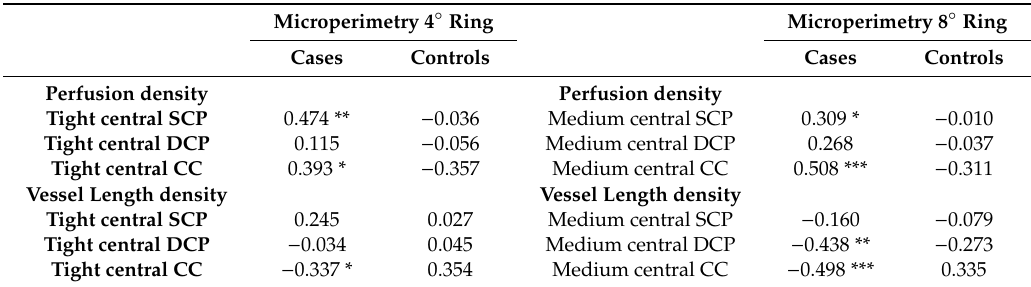
Table 7. Pearson’s correlation coe ffi cients between 4 ◦ and 8 ◦ microperimetry fields and tight and medium central sectors of perfusion density and vessel length